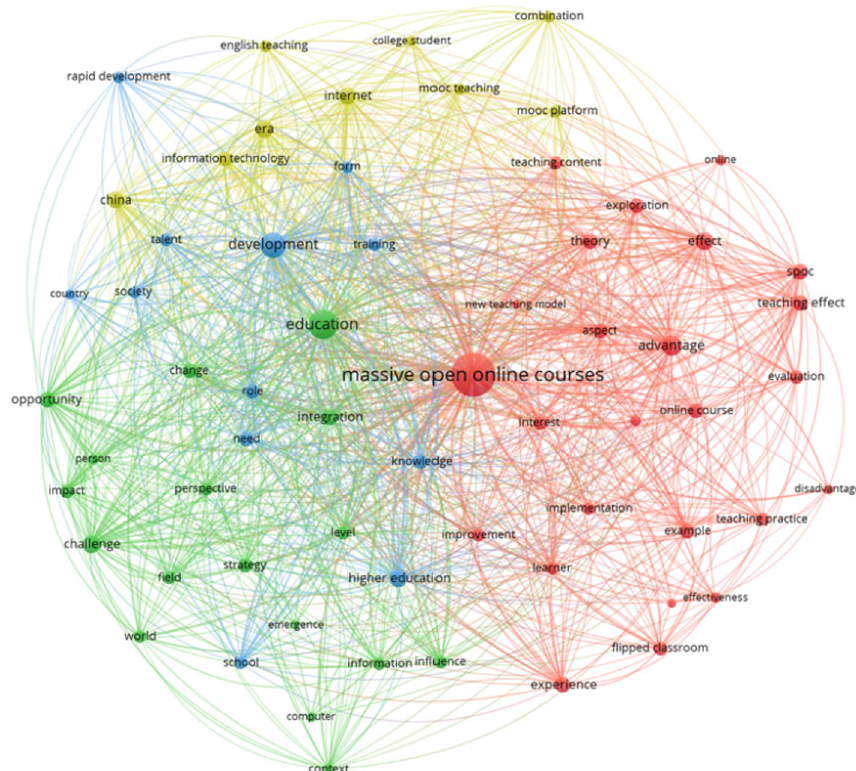
Fig. 4 Thematic cluster pedagogical approach of MOOCs. Network